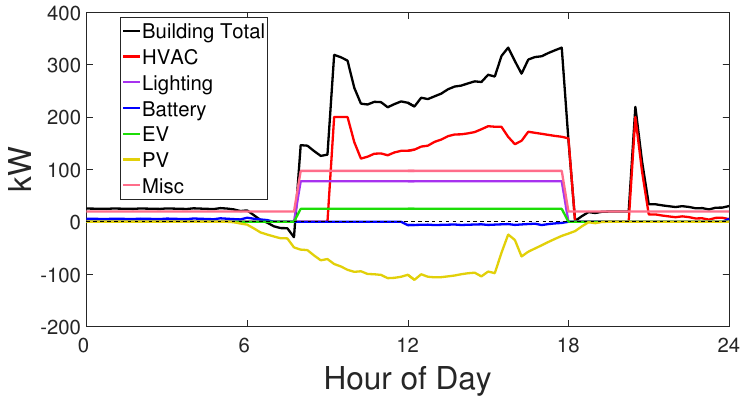
Figure 2. Power consumption profiles for the building and the individual subsystems under rules-based control scheme over a 24 h period.